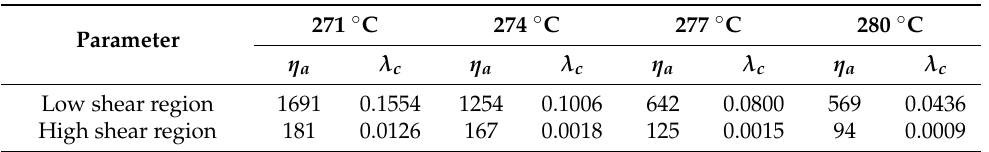
Figure 7. ( a ) Pressure inside the die channel for PET melts and ( b ) pressure along the die exit for PET melt at different temperatures.